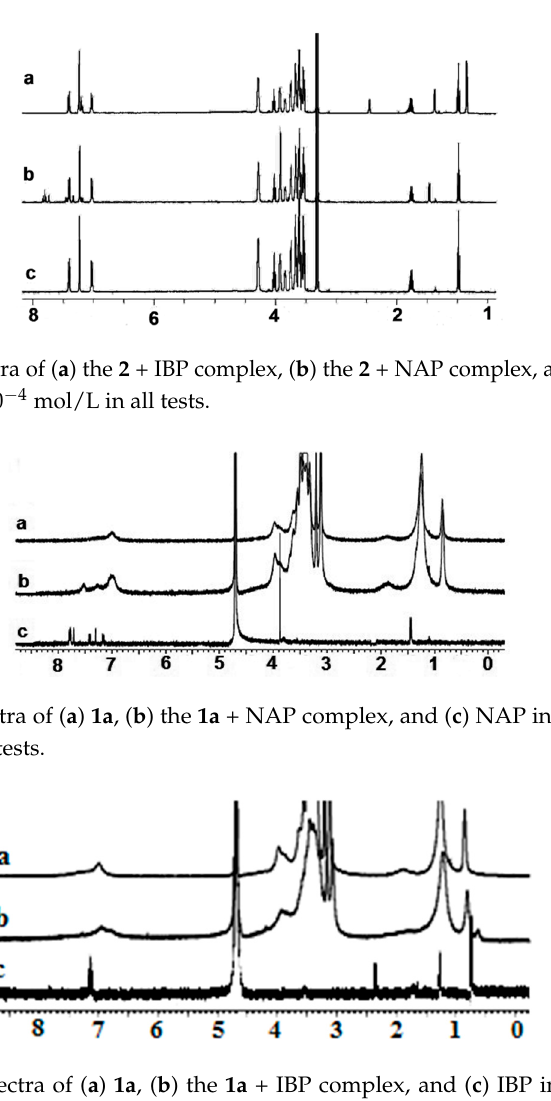
Figure 8. 1 H-NMR spectra of ( a ) the 2 + IBP complex, ( b ) the 2 + NAP complex, and ( c ) 2 in D 2 O, [ 2 ] = [NAP] = [IBP] = 1.0 × 10 − 4 mol/L in all tests.